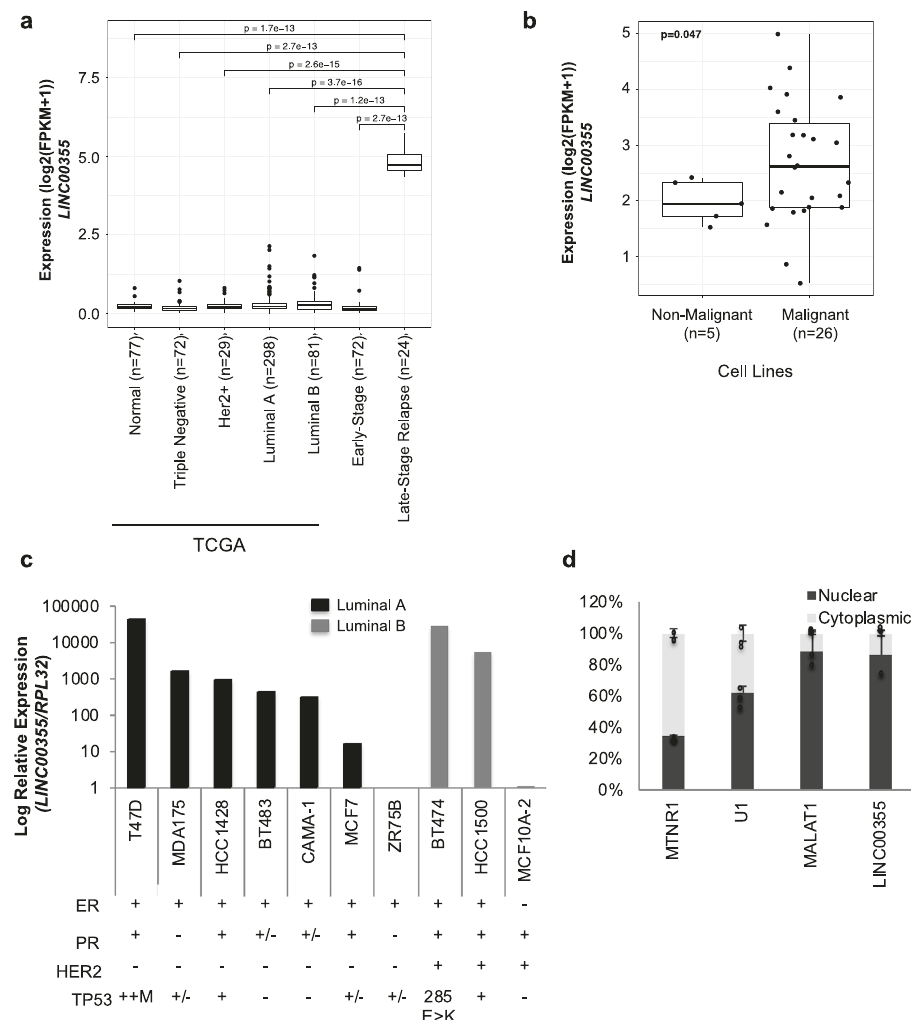
Fig. 2 LINC003355 characterization in breast cancer . a Expression of LINC00355 in primary tumors from the The Cancer Genome Atlas (TCGA) and early-stage and late-stage relapse from patient cohorts. b Sequence expression of LINC00355 in cell line panels and c qPCR from in-house cell lines showing subtypes. Estrogen Receptor (ER), Progesterone receptor (PR), Human epidermal growth factor receptor 2 (HER2), Tumor protein 53 (TP53), Mutation (M) d Nuclear localization of LINC00355 in T47D. MTNR1 (cytoplasmic positive control), U1, and MALAT1 (nuclear positive controls). All data are presented as mean values ± s.d., analyzed by two-tailed paired t -test, and repeated more than two times. Source data are provided as a Source Data